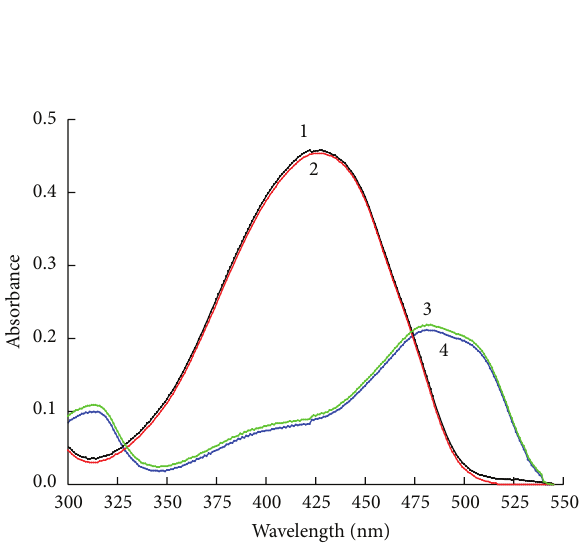
Figure 6: The UV-Vis spectra of colorants before and after extrac- = 100 𝜇 g, 𝑚 = 100 𝜇 g, 𝑉 = 0.30 mL, 𝑚 = 3.0 tion ( 𝑚 SY Ta IL K 2 HPO 4